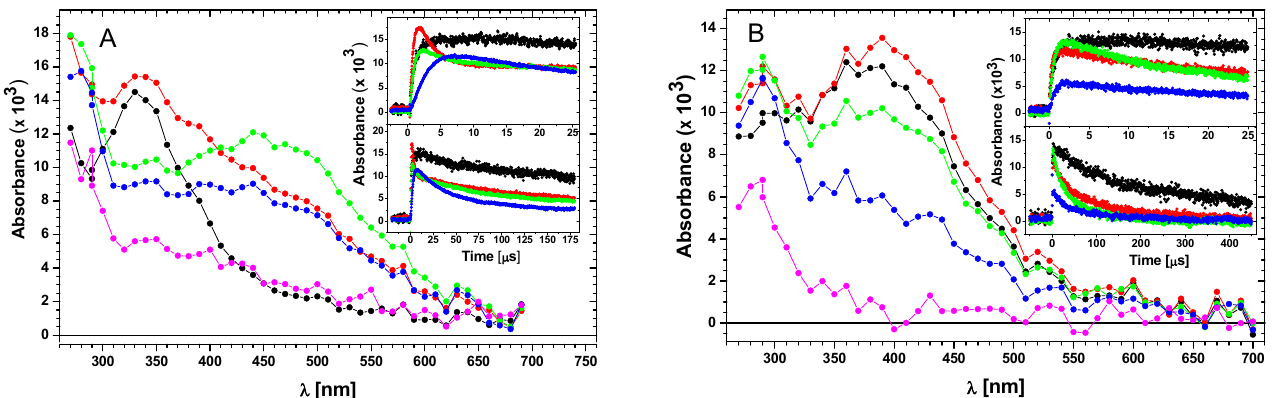
Figure 1. Absorption spectra recorded in N 2 O-saturated aqueous solutions at pH 7 containing 0.2 mM of Met derivative 1 ( A ) and S-methylcysteine derivative 2 ( B ). Spectra were taken after the fol- lowing time delays: 1 µs ( ), 3 µs ( ), 10 µs ( ), 30 µs ( ), and 160 µs ( ). Top insets: short-time profiles representing growths and decays at λ = 290 nm ( ), 340 nm ( ), 390 nm ( ), and 490 nm ( ). Bottom insets: long-time profiles representing decays at λ = 290 nm ( ), 340 nm ( ), 390 nm ( ), and 490 nm ( ). Dose per pulse = 11 Gy; optical path = 1 cm.